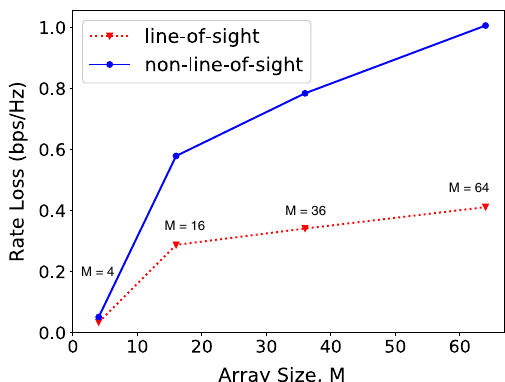
Fig. 10 Rate loss changing with base-station array size. The plot is based on measured channels